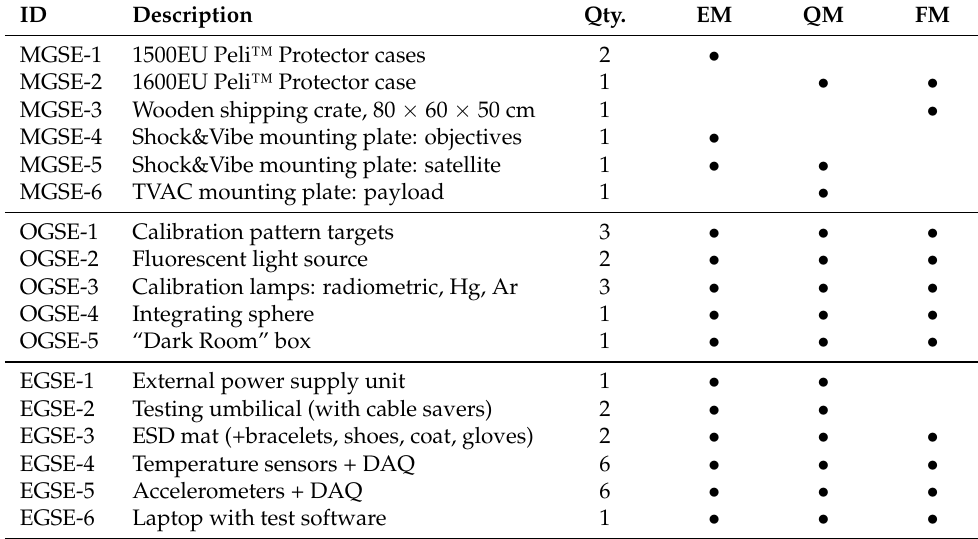
Table 3. Summary of GSE for AIT activities at NTNU. Selected GSE used for development